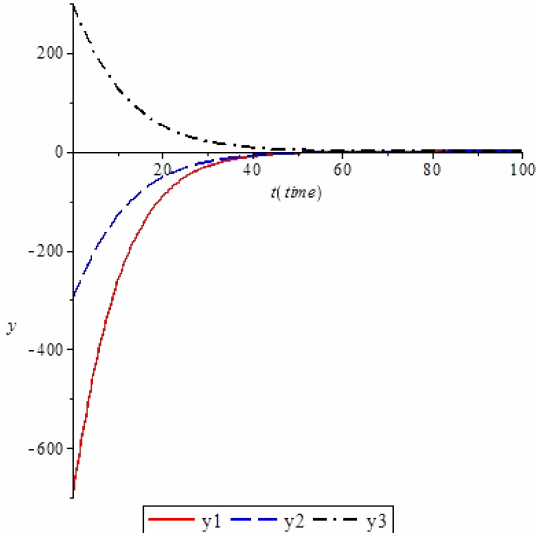
Fig. 1. Graphs of optimal trajectories y ð t Þ .